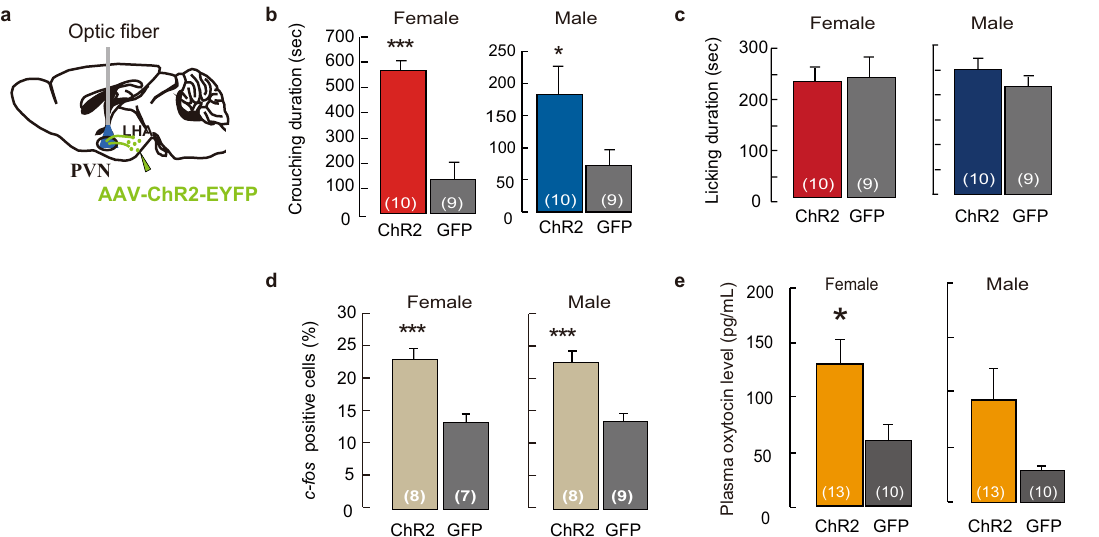
Figure 6. Optogenetic activation of MCH ChR2-expressing fibres prompts parental nursing behaviour in the PVN. ( a ) Illustration of optogenetic stimulation in the PVN with ChR2-EYFP fibre from MCH neurons. ( b ) Duration of crouching and ( c ) licking during optogenetic stimulation in the PVN. ( d ) The percentage c-fos positive oxytocin neurons in which ChR2 -expressed fibres were stimulated in the PVN. ( e ) Oxytocin levels in plasma samples after optogenetic stimulation in the PVN. Mean ± S.E.M. t-test, *** p < 0.001, * p <